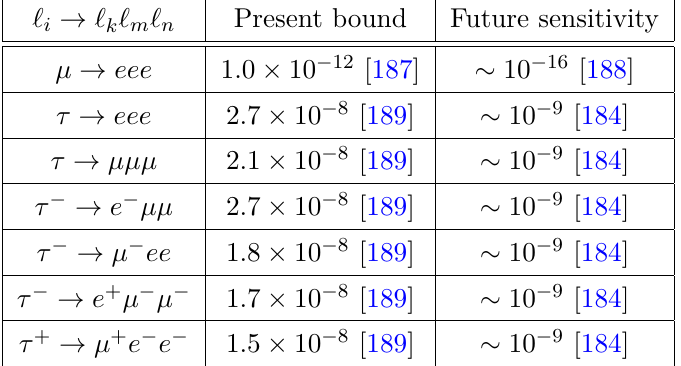
Table 3 . Current experimental bounds on the BR ( ‘ i → ‘ k ‘ m ‘ n ) . Future sensitivities are presented on the last